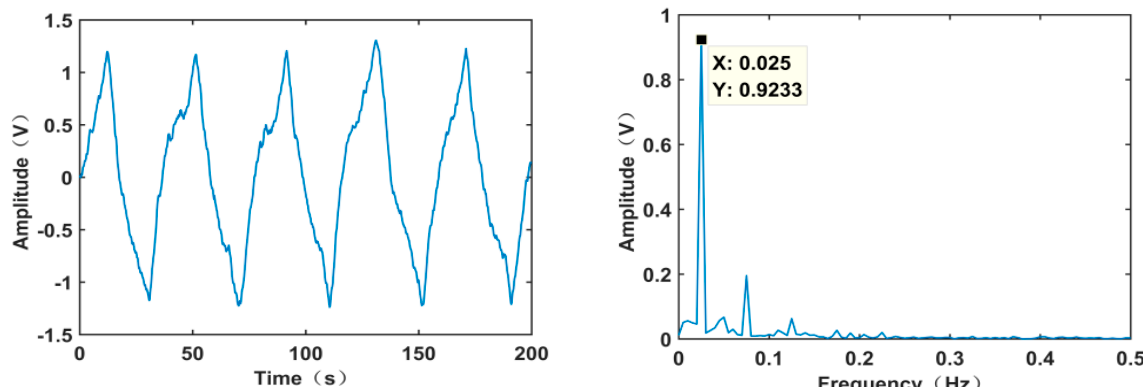
Figure 7. Time-domain waveform and amplitude spectrum of SR output signal.